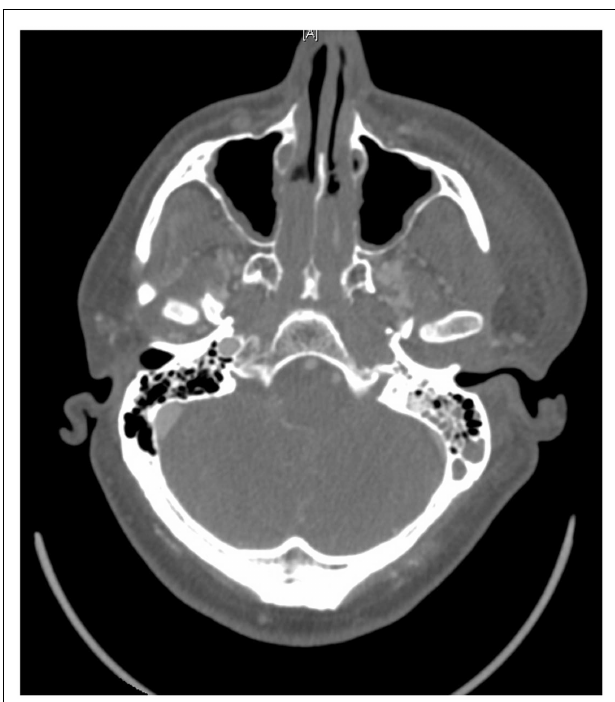
FIGURE 8 | Post-operative follow up CT scan showing lack of flow through the left ICA